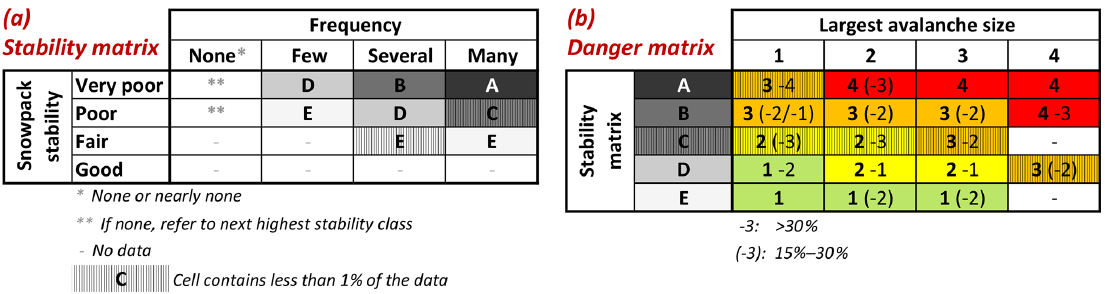
Figure 6. Data-driven look-up table for avalanche danger assessment (similar to the structure proposed by Müller et al., 2016). (a) The stability matrix combines the frequency class of the most unfavorable snowpack stability class (columns) and the snowpack stability class (rows) to obtain a letter describing specific stability situations. (b) The danger matrix combines the largest avalanche size (columns) and the specific stability situations (letter) obtained in the stability matrix (rows) to assess the danger level. In (b) the most frequent danger level is shown in bold. If the second-most-frequent danger level was present in more than 30% of the cases, the value is shown with no parentheses; if it was present in between 15% and 30%, it is placed in parentheses. In (a) and (b) cells containing less than 1% of the data are marked.